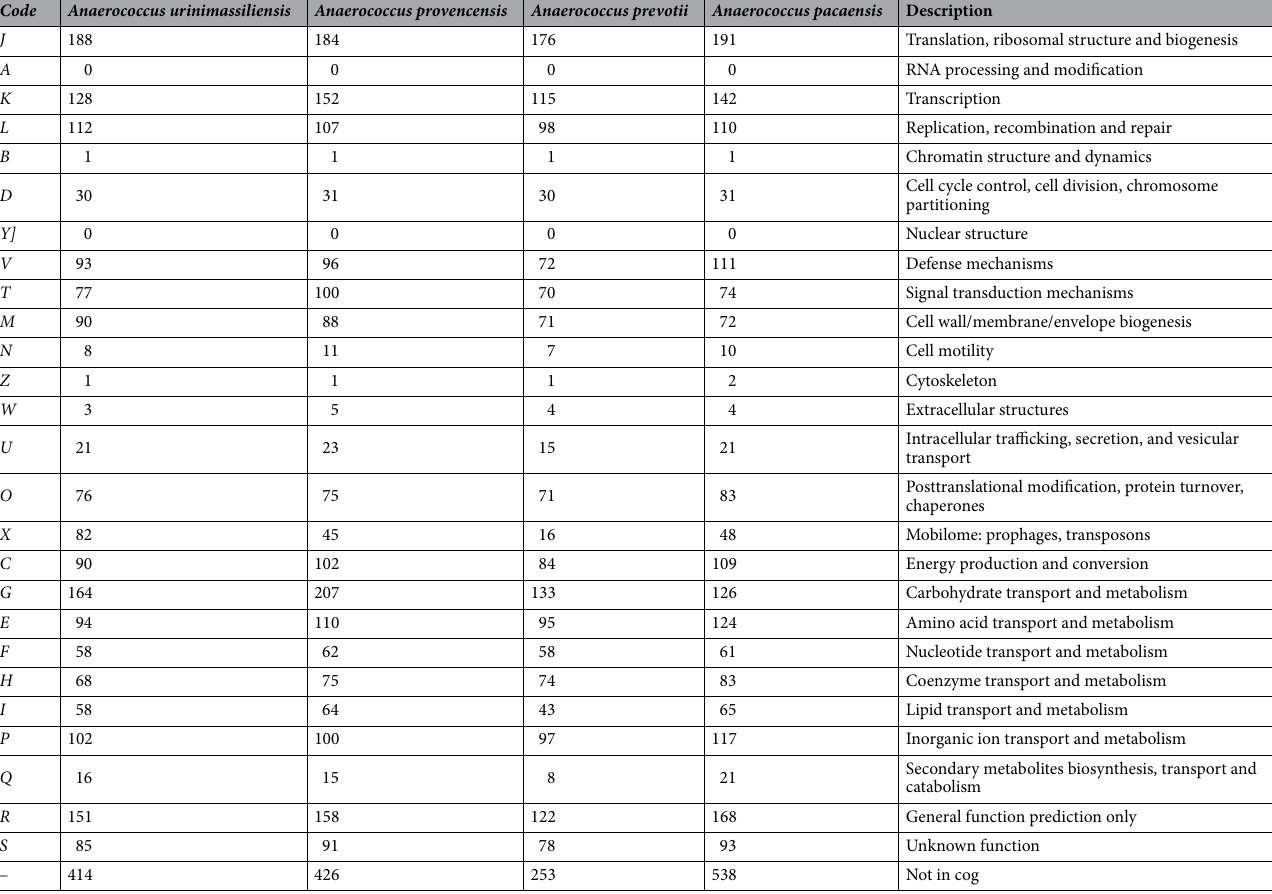
Table 5. Number of genes associated with the 25 general clusters of orthologous group (COG) functional categories of strain Marseille-P2143 with other species within the family Peptoniphilaceae